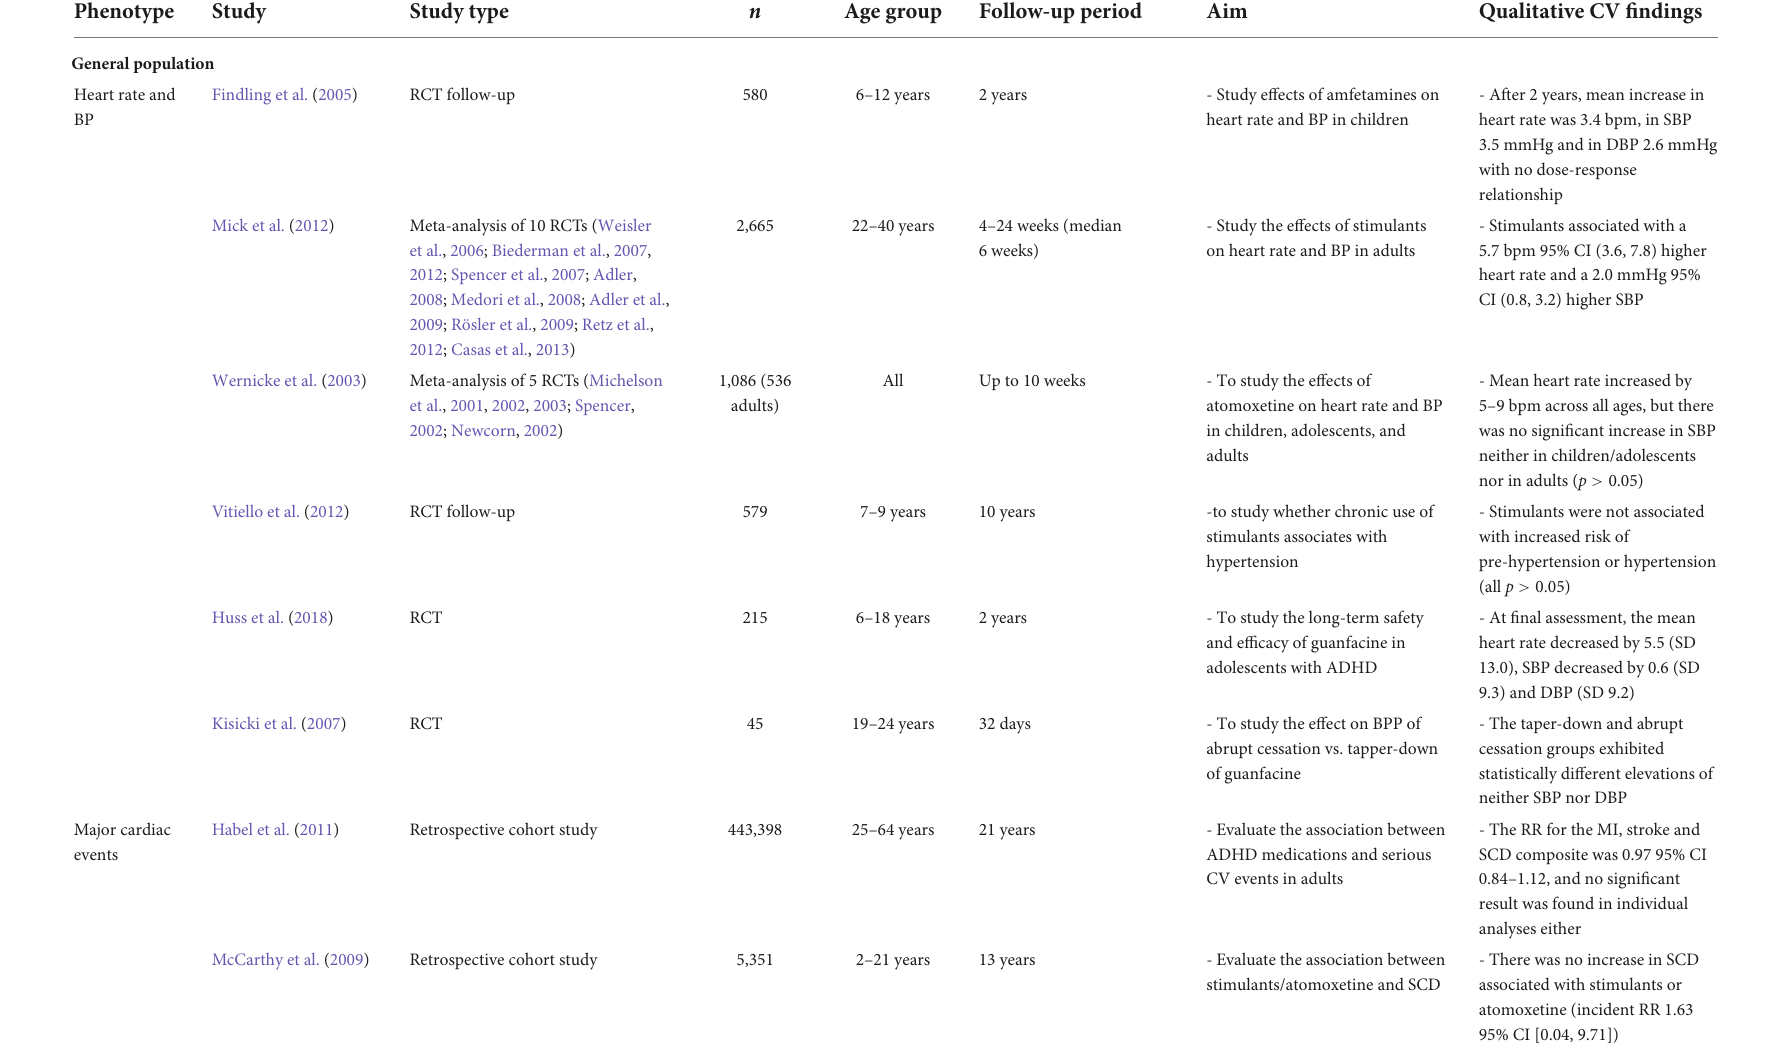
TABLE 2 Quantitative data relating the effects of ADHD medications on cardiovascular